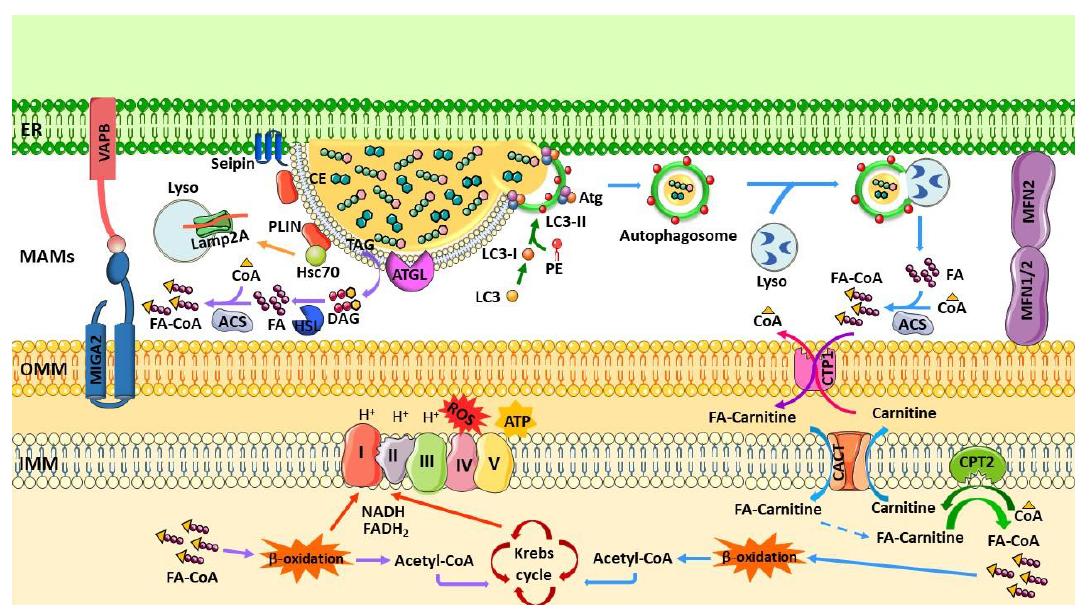
Figure 2. Breakdown of lipid droplets by lipolysis and lipophagy. ER and mitochondria can interact through complexes VAPB-Miga2 and MFN2-MFN1/2. Under nutrient depletion or cell growth, the core of LDs can be mobilized by lipolysis or lipophagy. Hsc70 recognizes LDs-associated proteins PLIN and translocates this protein into the lysosome via Lamp2A for degradation, facilitating access of the lipid core to cytosolic lipase ATGL. TAG is converted to DAG by ATGL and DAG to FAs by HSL protein. Similarly, elimination of PLINs also enables proteins involved in autophagosome formation (Atg and LC3) to anchor on LDs and initiate sequestration of regions of LDs in autophagosomes. Autophagosomes are delivered to lysosomes for degradation by acid lipolysis. FAs released are converted in fatty acyl-CoA by acetyl-CoA synthetase (ACS) and transferred to the mitochondrial matrix by a carnitine shuttle constituted by CPT1, CACT, and CTP2. In mitochondria, β -oxidation of fatty acyl-CoA occurs, leading to production of acetyl-CoA that enters the Krebs cycle. NADH and FADH 2 generated both from β -oxidation and the Krebs cycle are the electron donors for the electron transport chain for ATP production, which is also associated with generation of ROS.Abbreviations: ACS, acetyl-CoA synthetase; ATG, autophagy-related protein; ATGL, adipose triglyceride lipase; CACT, carnitine-acylcarnitine translocase; CE, cholesteryl esters; CoA, coenzyme A; CPT1/2, carnitine-palmitoyltransferase 1/2; DAG, diacylglycerol; ER, endoplasmic reticulum; FA, fatty acid; FA-CoA, fatty acyl CoA; Hsc70, heat-shock-associated protein; HSL, hormone-sensitive lipase; IMM, inner mitochondrial membrane; Lamp2A; lysosome-associated membrane protein 2A; LC3, microtubule-associated protein 1A/1B-light chain 3; LD, lipid droplets; Lyso, lysosome; MAMs, mitochondria-associated membranes; MFN1/2, mitofusin 1/2; Miga2, mitoguardin 2; OMM, outer mitochondrial membrane; PE, phosphatidylethalonamine; PLIN, perilipin; TAG, triacylglycerol; VAPB, vesicle-associated membrane-protein-associated protein